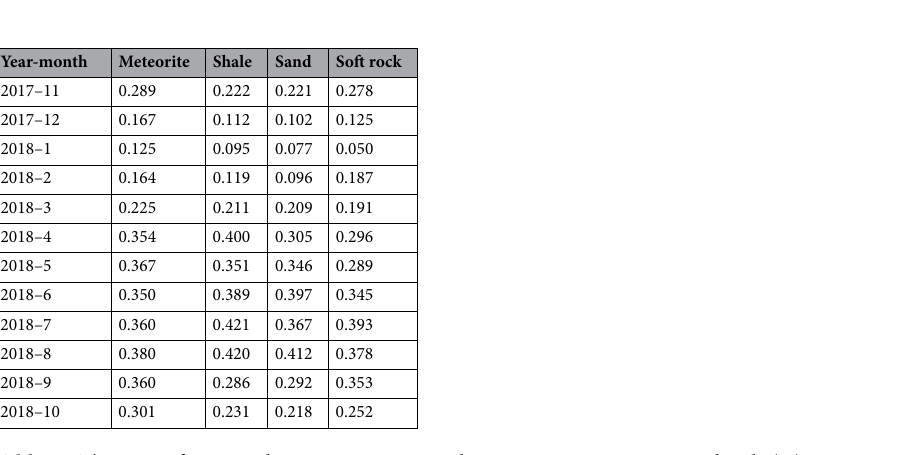
Table 2. The ratio of autotrophic respiration to total respiration in reconstructed soils